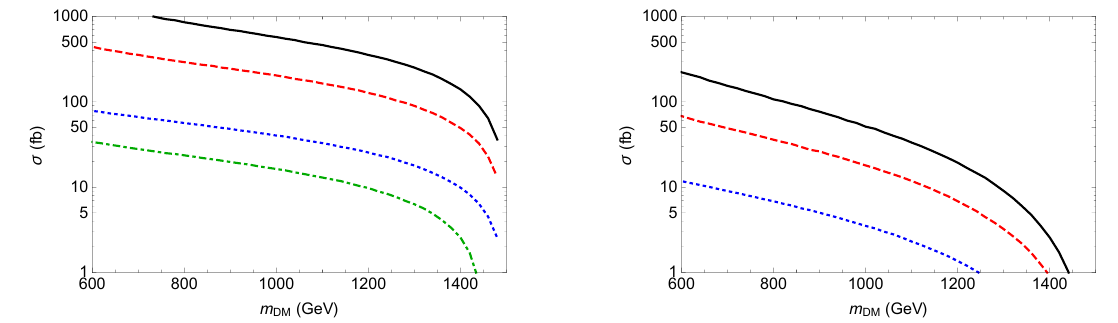
Figure 3 . Cross sections (after cuts and detector e(cid:11)ects) for the LLCP signals, for fermions (left) and scalars (right). The black solid (red dashed, blue dotted, green dot-dashed) line shows the result for the septet (quintet, triplet, doublet) representation. For comparison, the background cross section is 0.15